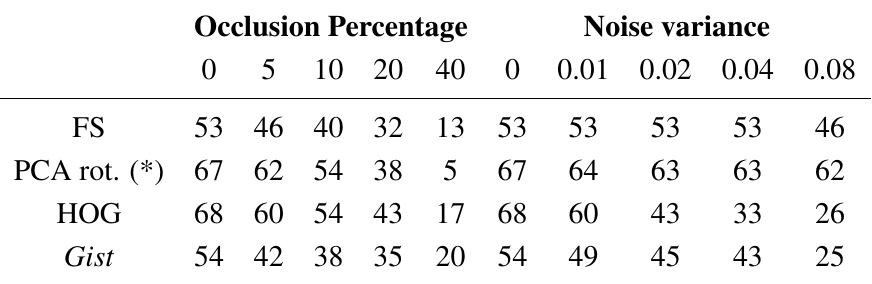
Table 1. Quorum database. Precision (%) in localization when the test images present occlusion or